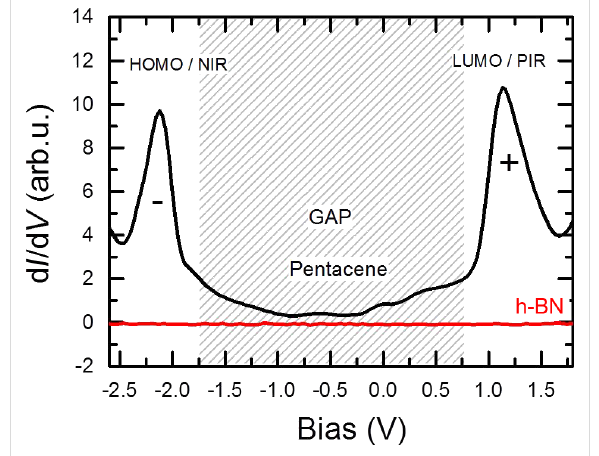
Figure 2: STS of pentacene on h-BN/Rh(111) showing the reso- nances of the frontier molecular orbitals. The red curve depicts the d I /d V of bare h-BN. Zero bias refers to the Fermi energy of the Rh sub- strate.